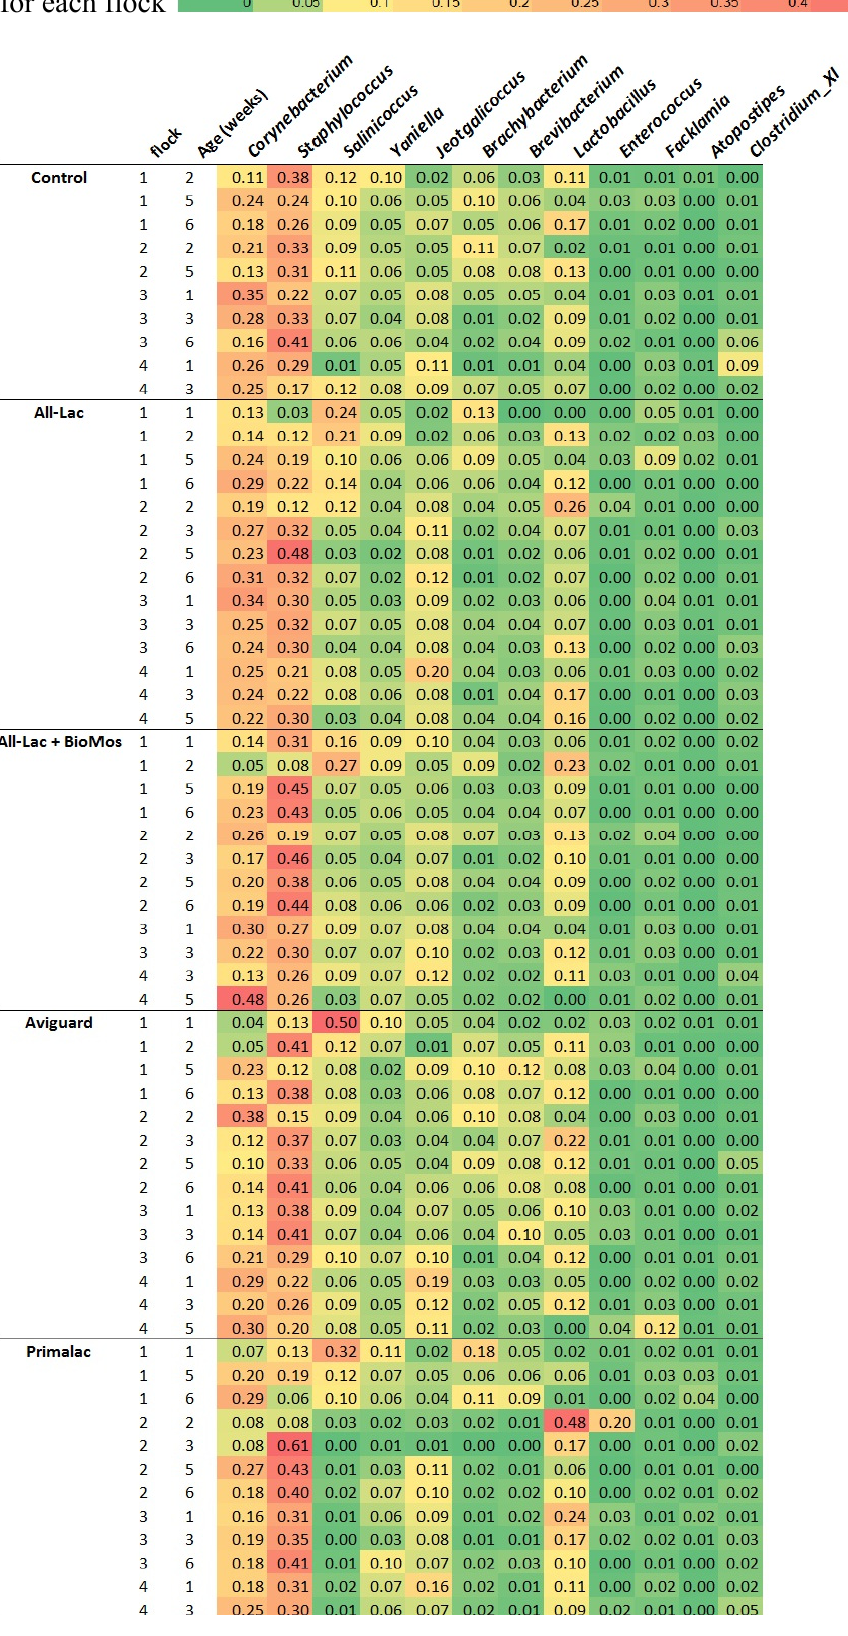
Figure 2. Abundance of genera contributing greater than 1% to total number of 16S rRNA sequences of 4 sequential flocks of broiler chickens administered probiotics or prebiotics and reared in research housing. The abundances are shown as the proportion of total sequences for each flock